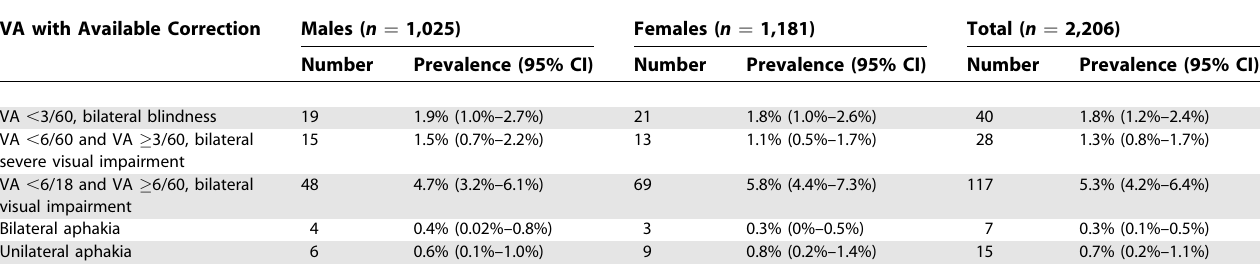
Table 2. Distribution by Visual Acuity with Available Correction in the Better Eye in Adults Aged 50 Years and Older VA with Available Correction